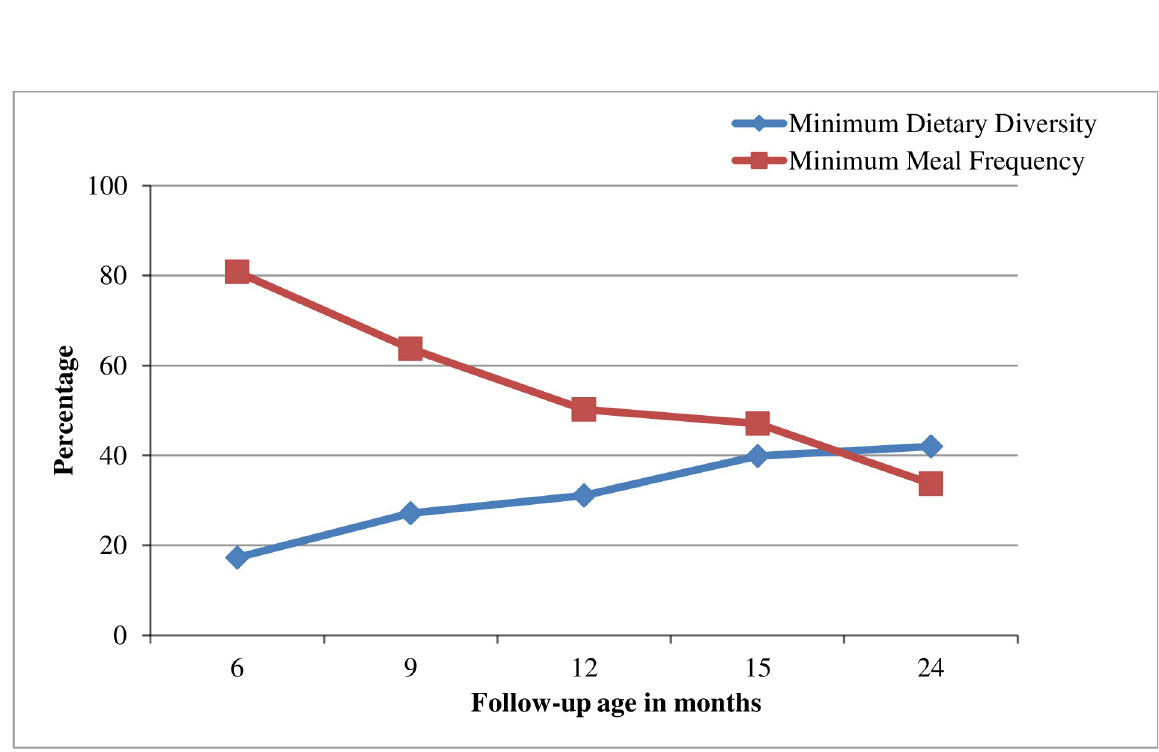
Fig 5. Proportion of children who adhered to the minimum meal frequency and minimum dietary diversity across follow up visits.